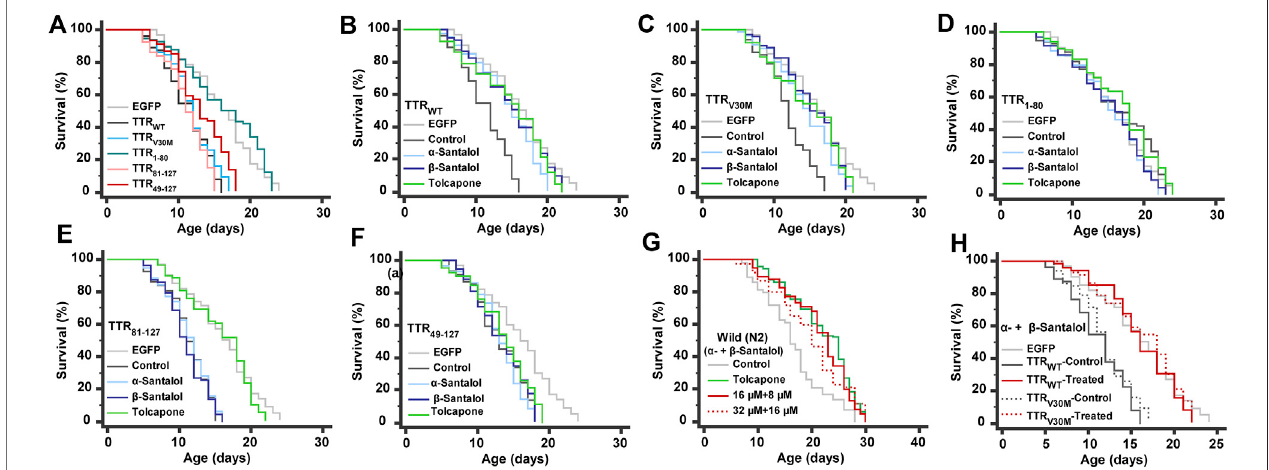
FIGURE 4 | Lifespan analyses. (A) The lifespan of worms expressing various TTR fragments. (B – F) Effect of α - and β -santalol on the lifespan of TTR protein- expressing worms. Synergistic effect of santalol isomers on the lifespan of (G) wild-type and (H) TTR transgenic worms. Combined data of three independent biological trials were presented. See Supplementary Tables S3 , S4 for statistical details of lifespan